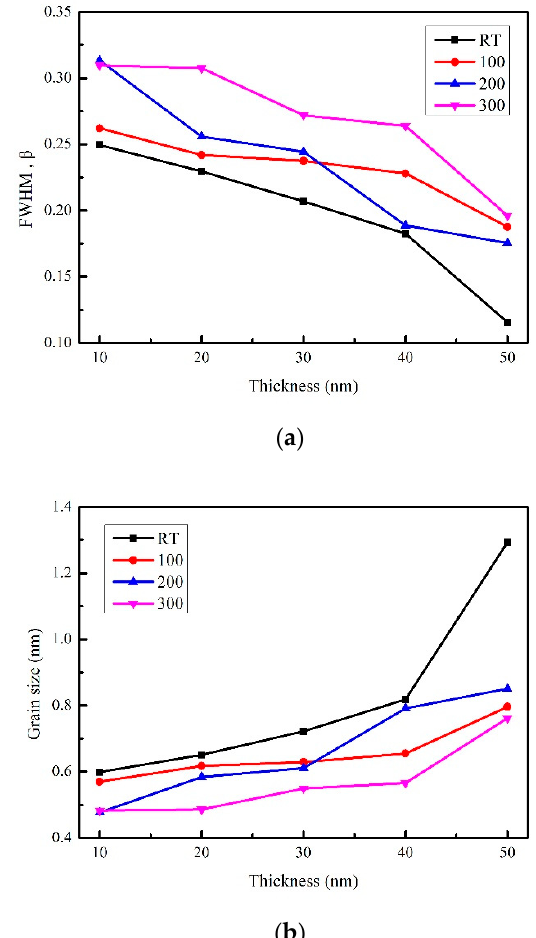
Figure 2. ( a ) The full width at half maximum (FWHM, B) of CoFeBY films, ( b ) the average grain size of CoFeBY films.